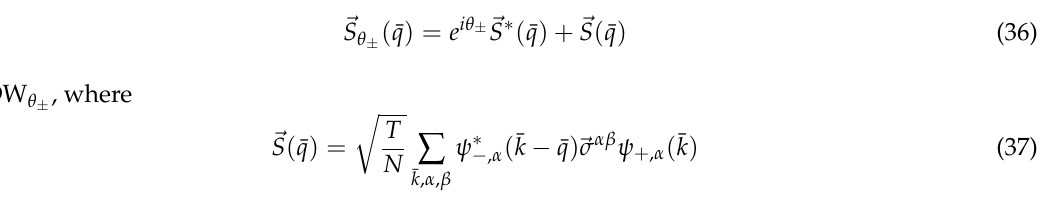
Figure 4. Site ( + ) and bond ( the alternated